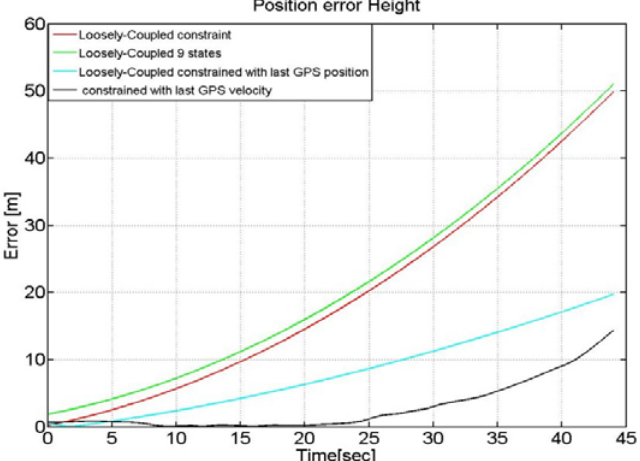
Figure 16. LC in case of GPS outage with weighting